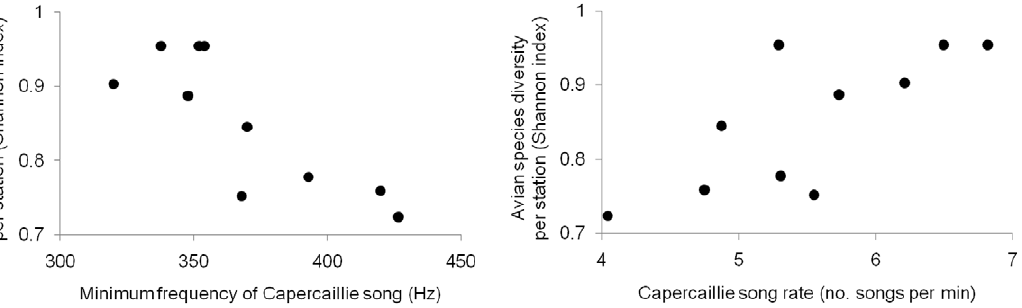
Figure 4. Relationships between Capercaillie song attributes and bird diversity. Bird species diversity decreases where the minimum frequency of Capercaillie song increases, and where Capercaillie sings at a faster